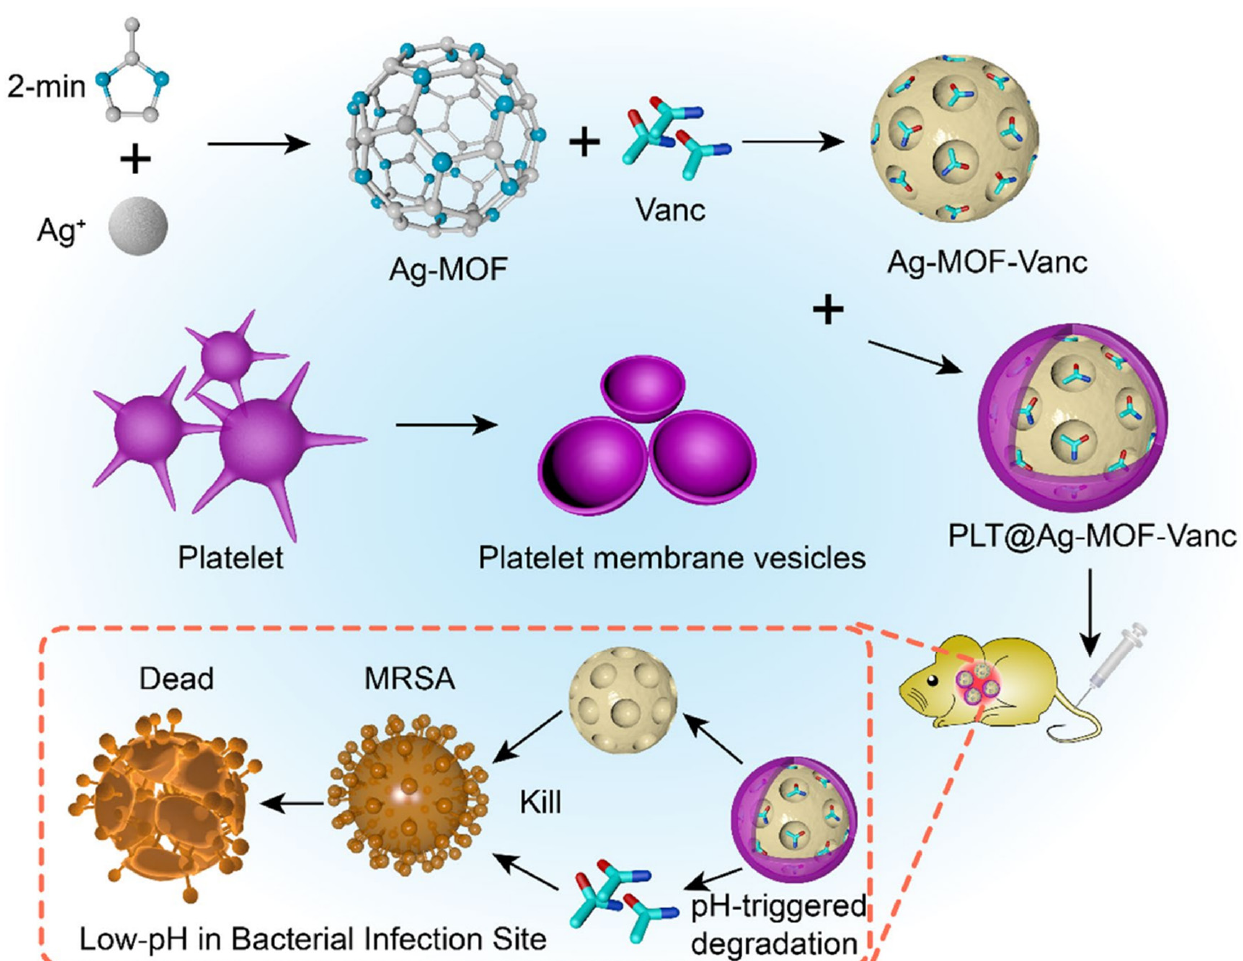
Figure 3. Schematic diagram of PLT@ Ag-MOF-Vanc in the treatment for a MRSA infection. Repro- duced with permission from [111].